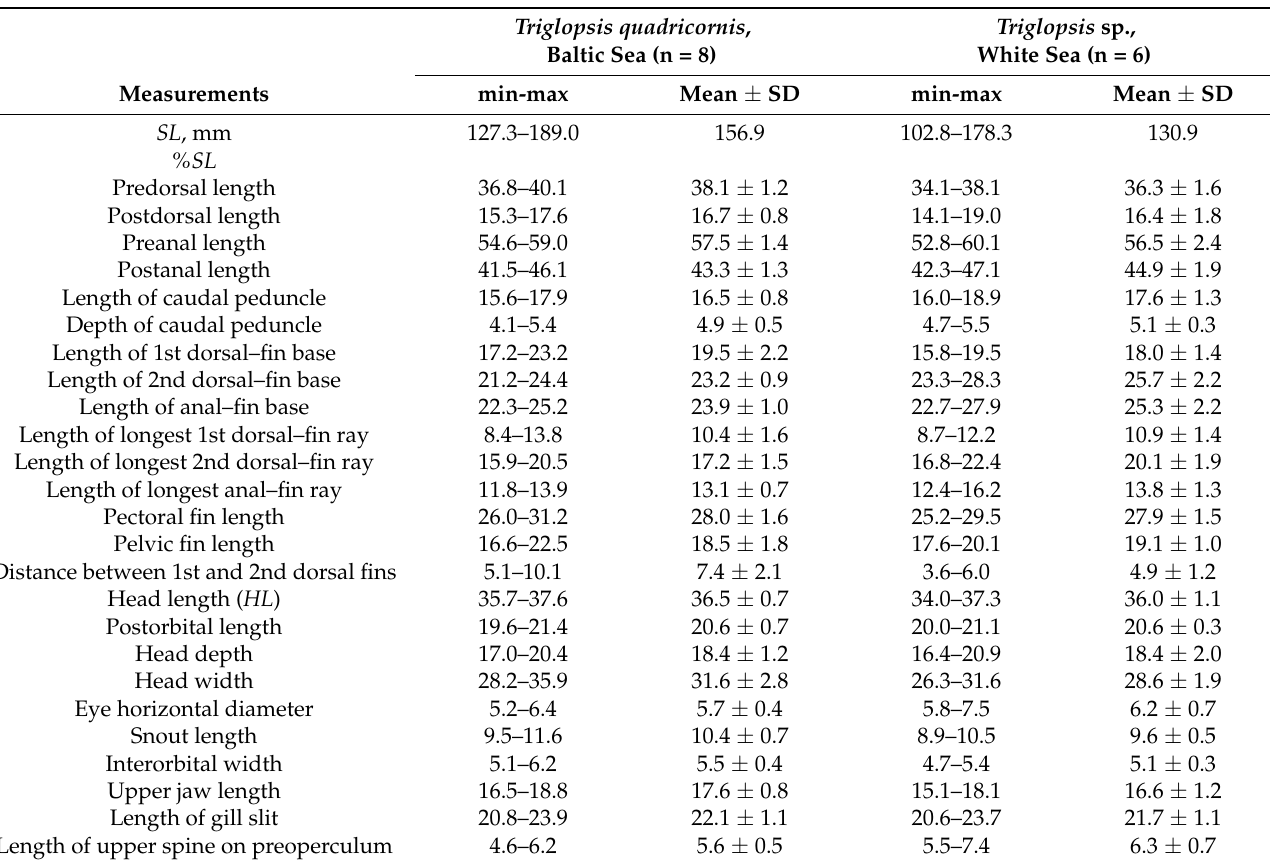
Table 1. Relative measurements for T. quadricornis from the Baltic Sea and Triglopsis sp. from the White Sea. The scheme of measurements is shown in Figure S1. Triglopsis quadricornis